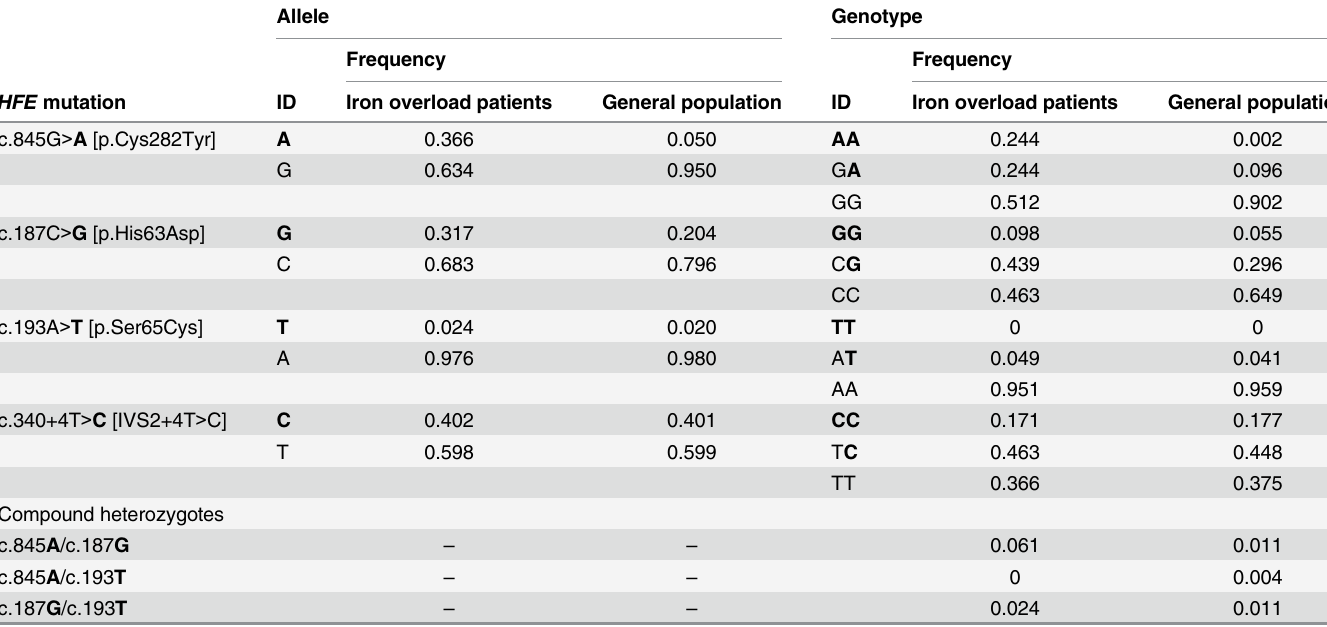
Table 4. Allele and genotype frequencies of HFE mutations in patients with iron overload and in the general population from S ã o Miguel Island.